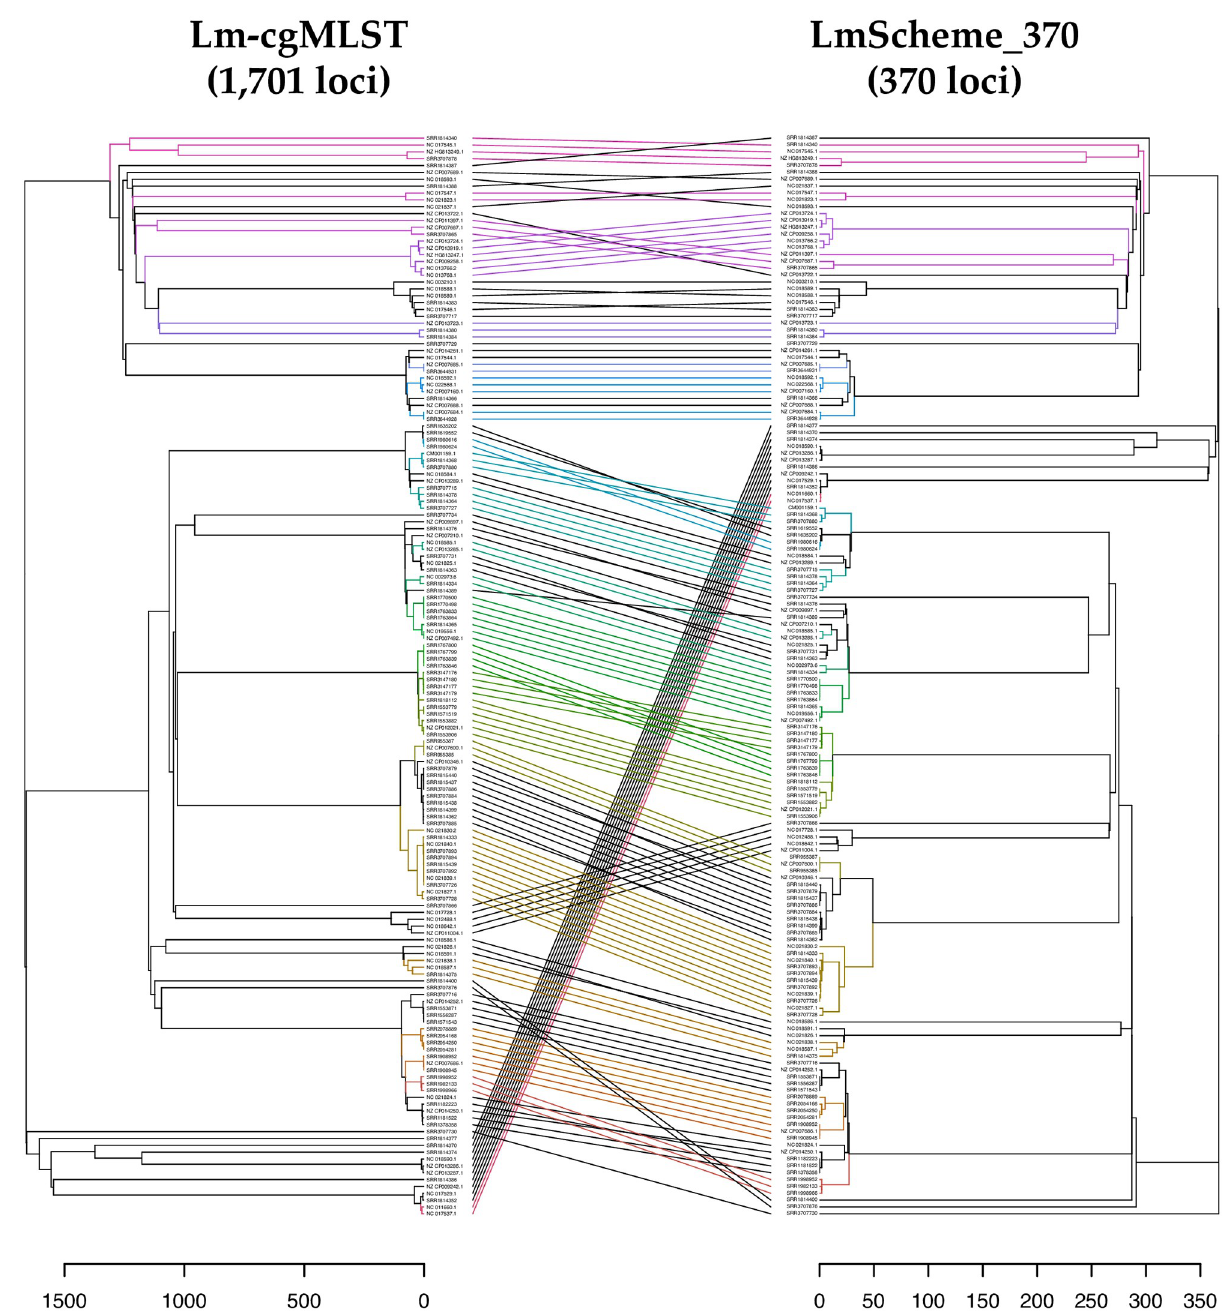
Fig 3. Tanglegram of dendrograms calculated based on Lm-cgMLST (1,701 loci) and LmScheme_370 allelic profiles from Set A. Both allelic distance scales are displayed. The same isolate in each dendrogram connected with a line; the colors have no meaning but are used for easier visualization.